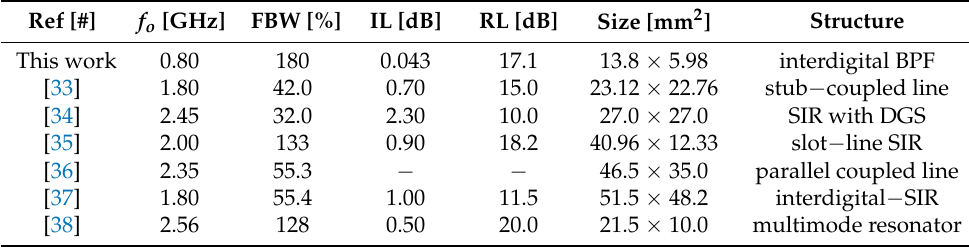
Table 2. Comparison of the sizes and FBWs of